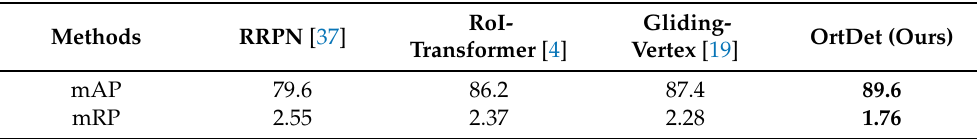
Table 3. Mean average precision (%) and mean rotation precision of the different methods for the HRSC2016 dataset.